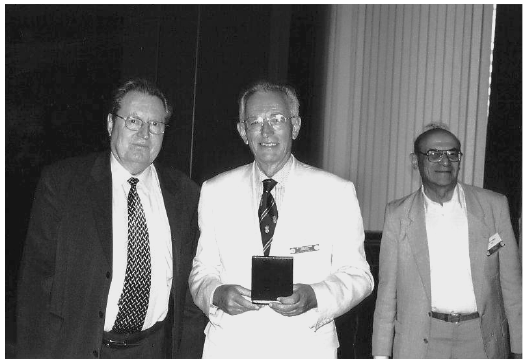
Figure 4 (left above): From the left: Prof. H. Schmid - Schonbein, Prof. Sandro Forconi, and Dr. Nadia Antonova. Figure 5 (right above): From the left: Prof. J.F. Stoltz, Prof. Sandro Sandro Forconi, and Prof. Vladimir Vorobyev. Figure 6 (left middle): Prof. Sandro Forconi with a part of the Italian group (From the left: